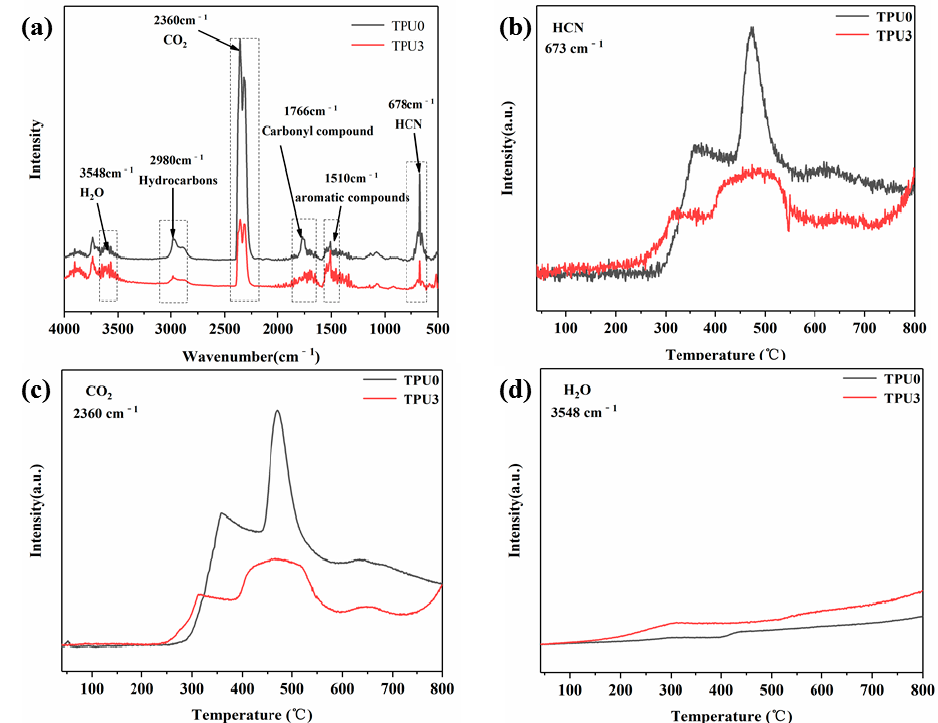
Figure 13. FTIR spectra of TPU0 and TPU3 pyrolysis products at maximum decomposition rate ( a ), the absorbance intensities of HCN ( b ), CO 2 ( c ) and H 2 O ( d ) of TPU0 and TPU3.